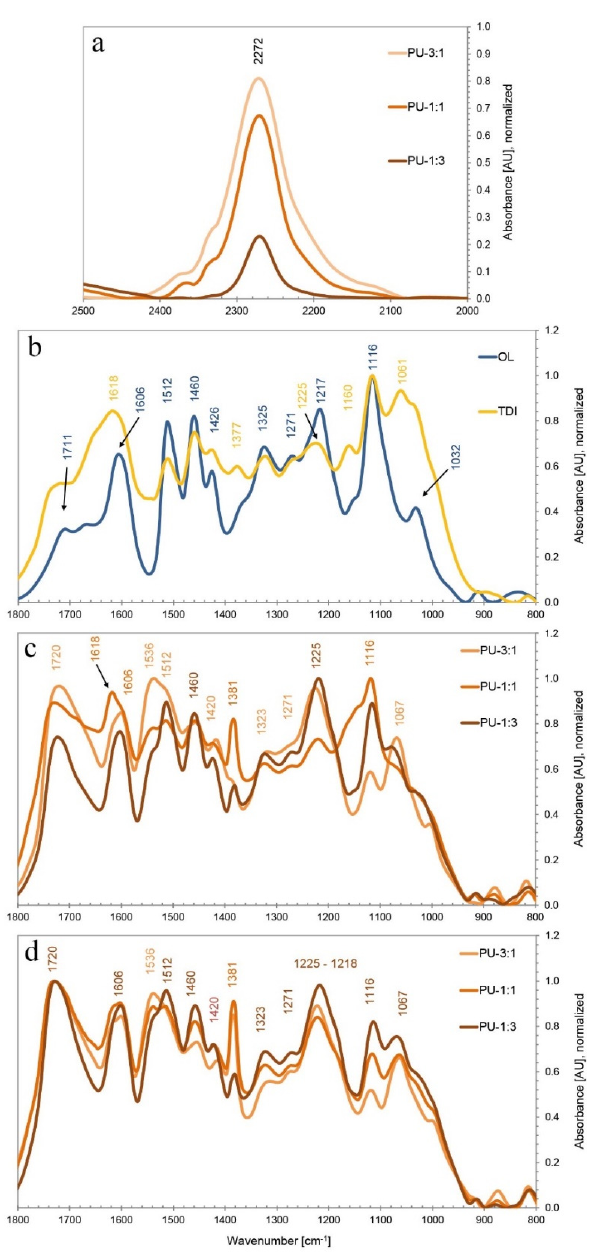
Figure 4. ( a ) Absorbance band of free isocyanate groups in the three different prepared PU formu- lations PU-3:1, PU-1:1 and PU-1:3. ( b ) FTIR spectra of Desmodur ® L75 and Organosolv lignin